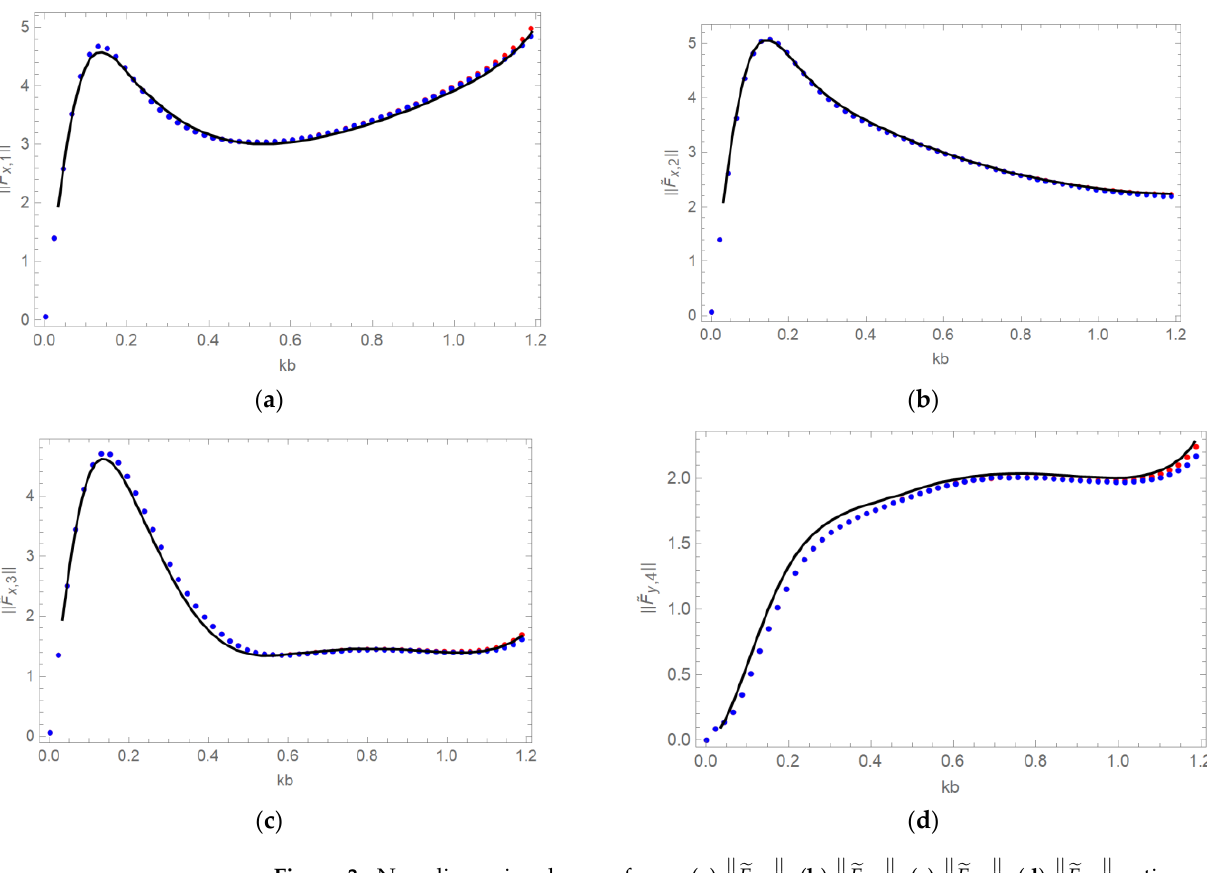
Figure 3. Non-dimensional wave forces ( a ) acting on the cylinders in Figure 2 with d / b = 2, β = 0 ◦ and h i = 1 m. Present solution with n = − 2, . . . ,10 (red dots), with n = − 2, . . . ,5 (blue dots), Ren et al. [19] (black line).